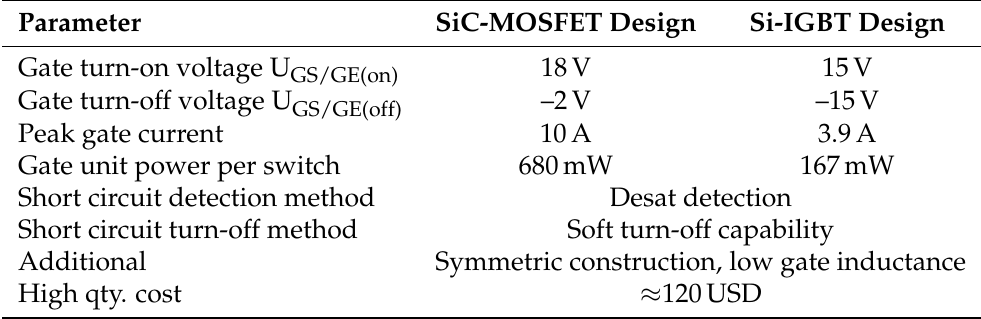
Figure 5. Gate unit for the characterization of SiC-MOSFET and Si-IGBT modules, as presented in [13]. Table 3. Gate unit